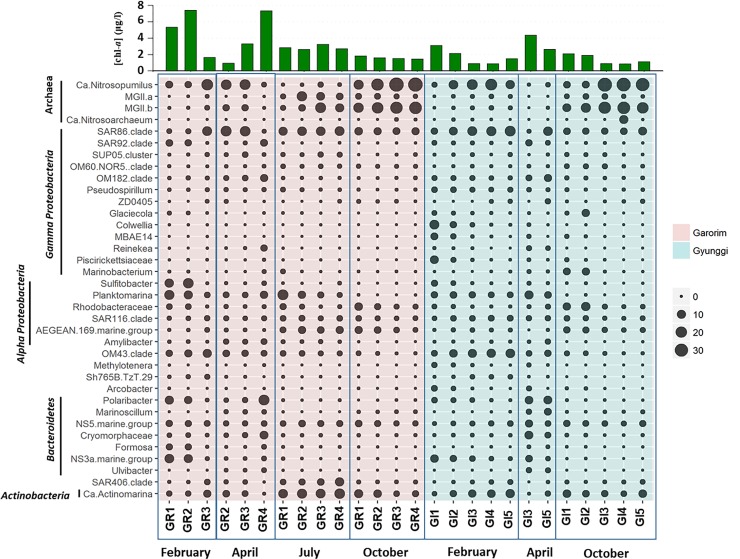
Taxonomic distribution of selected genera of dominant phyla of surface water microbiota in the two bays the Yellow Sea.[Chl-a] at each sample was shown at upper panel.